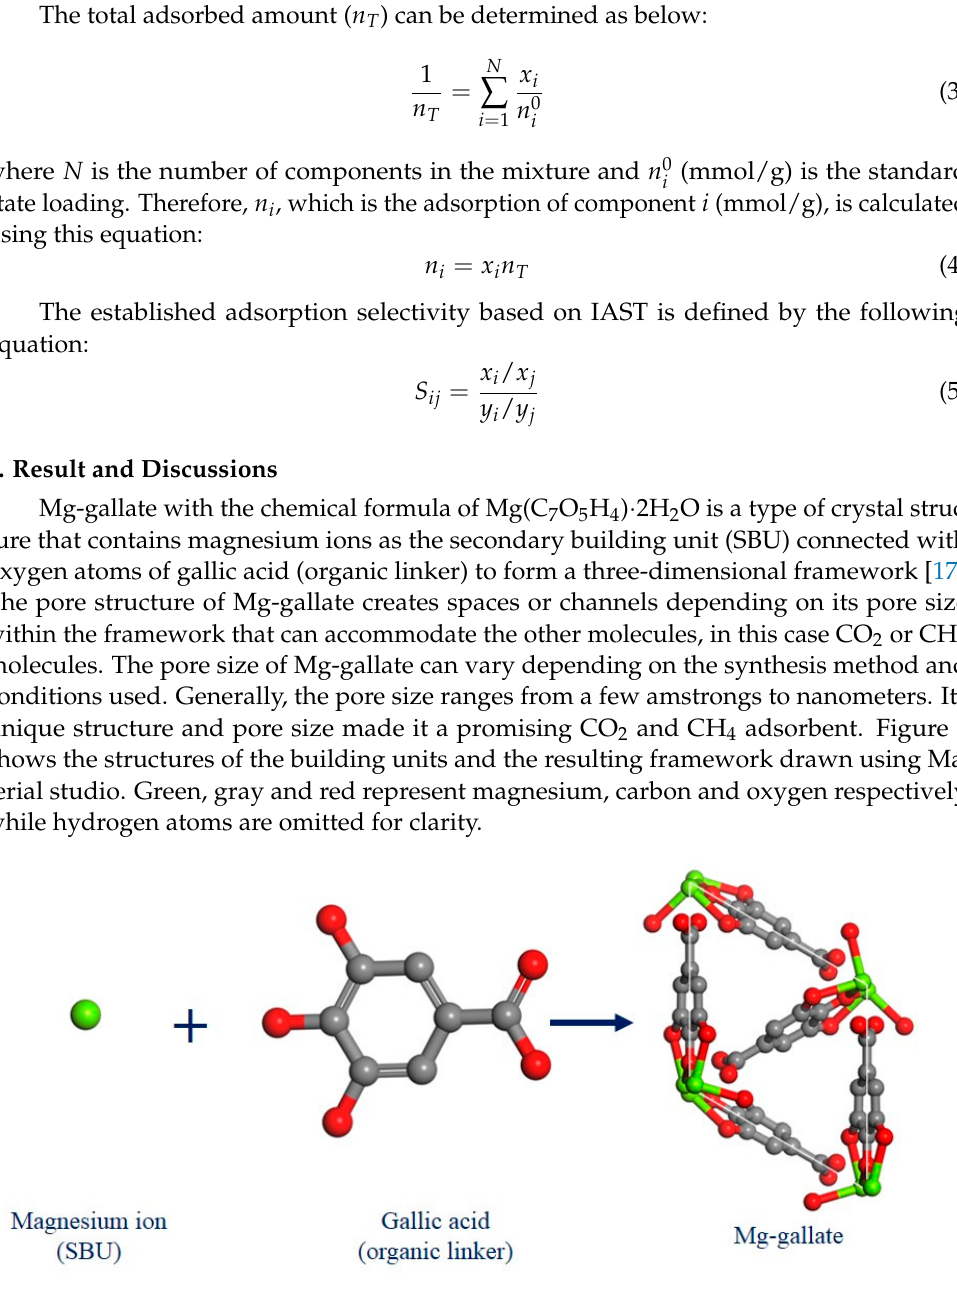
Figure 1. The structures of building units and Mg-gallate.